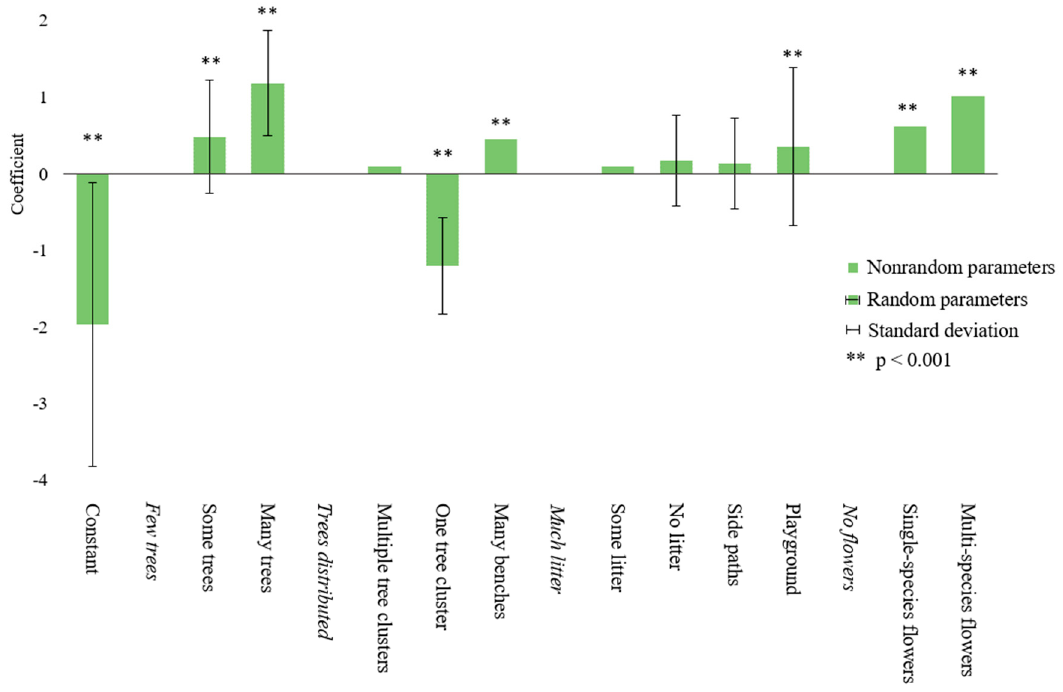
Figure 4. Diagram of the influence of the elements on preferences of the ML model. Elements with a significant random parameter are indicated by error bars, representing one standard deviation above and under the mean.